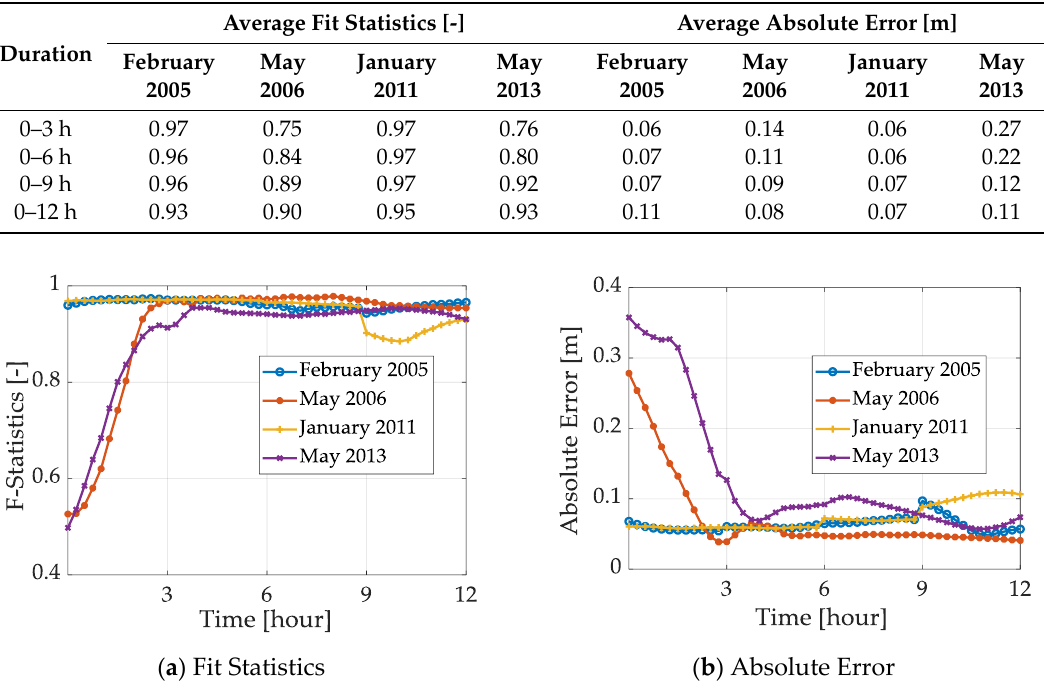
Figure 6. Goodness of fit ( a ) Fit Statistics and ( b ) Absolute Error between offline and online flooded cells for each time step for the forecast duration of 12 h.